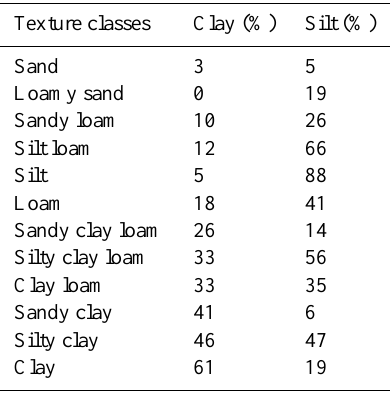
Table 1. Soil texture classes and their mass percentages of clay and